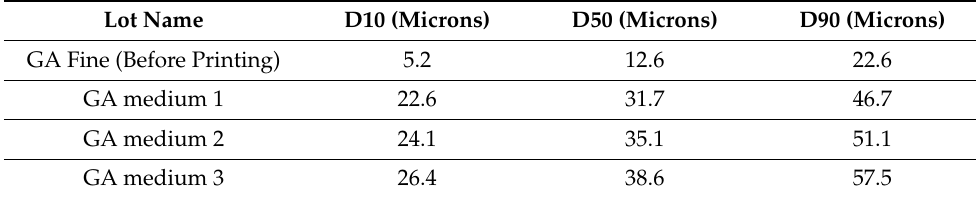
Table 1. Powder lots selected for characterization